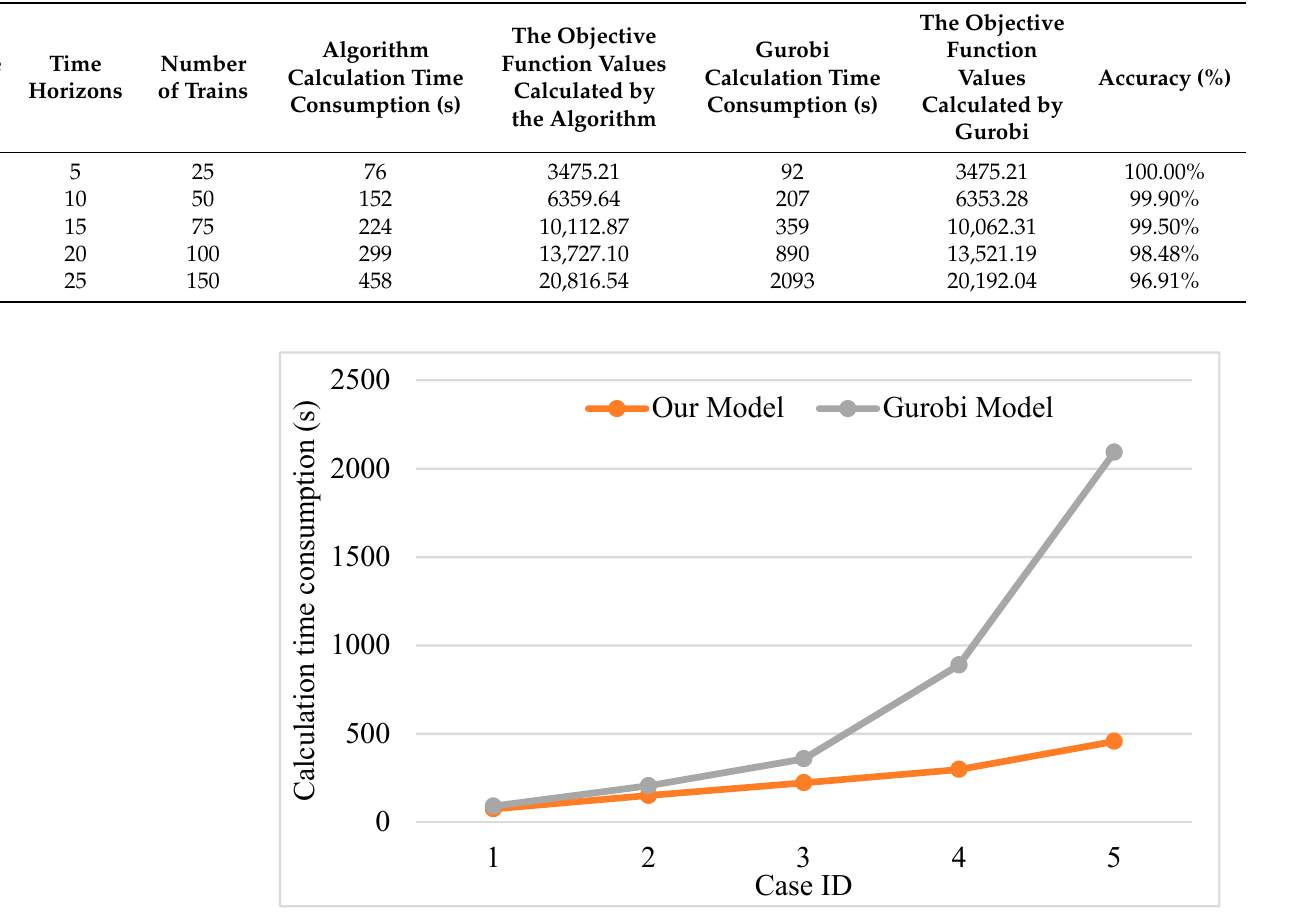
Figure 10. Solving time comparison.